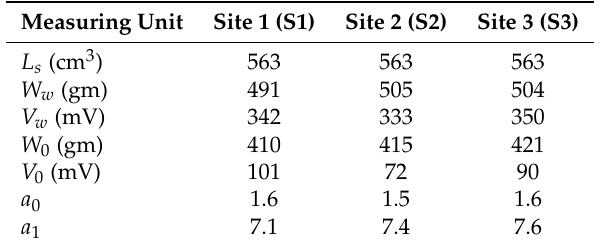
Table A1. Field derived calibration constants for MLT-3 theta